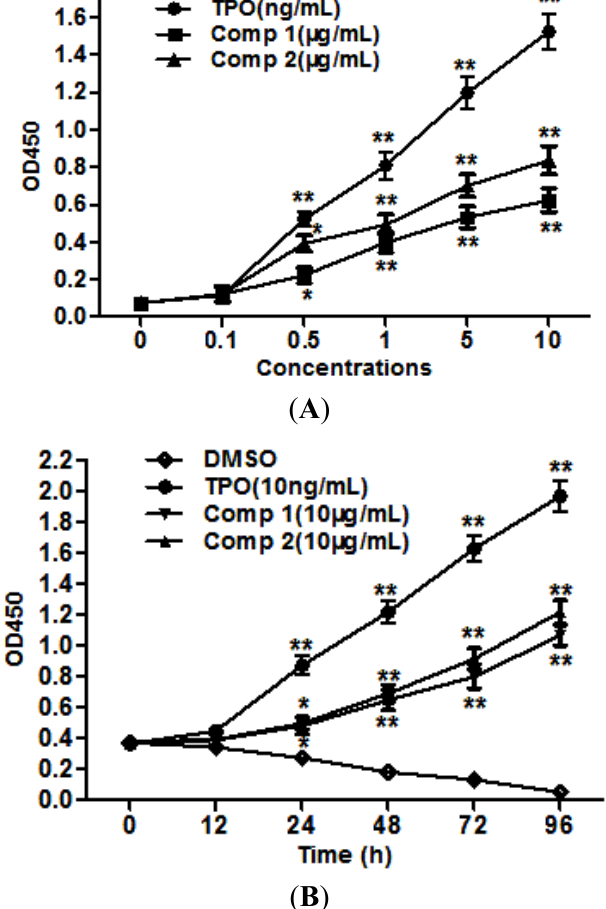
Figure 3. Compounds promote the proliferation of Baf3/Mpl cells. ( A ) Compounds 1 and 2 stimulate cell proliferation in a dose-dependent manner. ( B ) Compounds 1 and 2 stimulate cell proliferation in a time-dependent manner. Results are representative of at least three independent experiments run in triplicate and expressed as the mean ± SD.